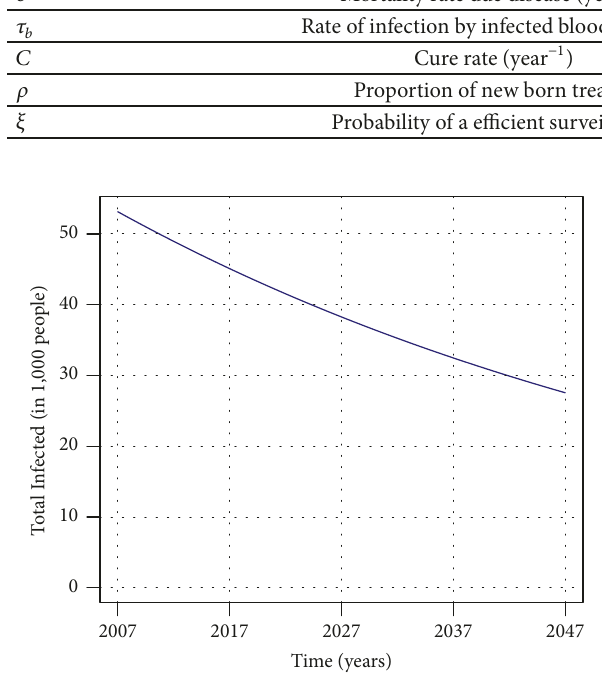
Figure 2: Dynamics on the number of total infected people along 40 years simulation considering death rate due to disease as twice the natural death rate and no migration flows.